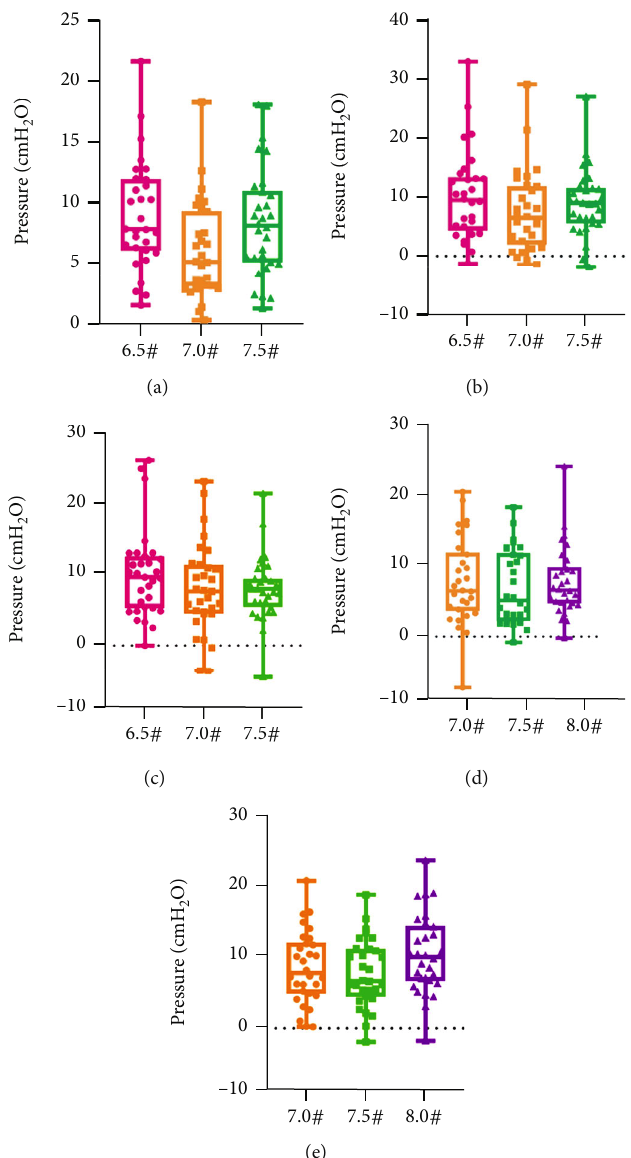
Figure 3: The di ff erence between the actual cu ff pressure and theoretical cu ff pressure inferred by the